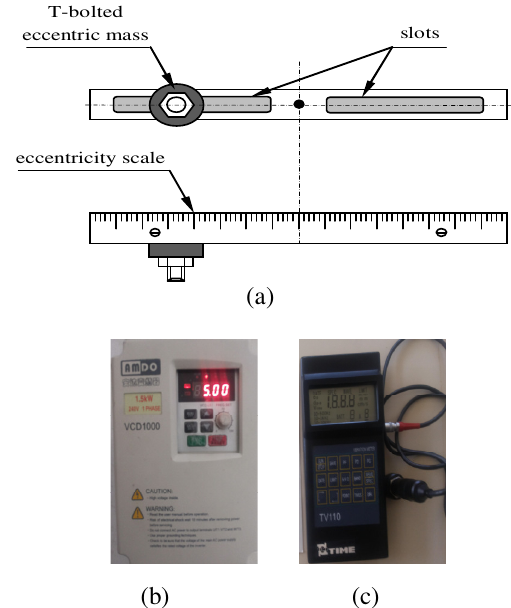
Fig. 6. Unbalance mass & eccentric mechanism, motor drive controller, and vibration meter with accelerometer details